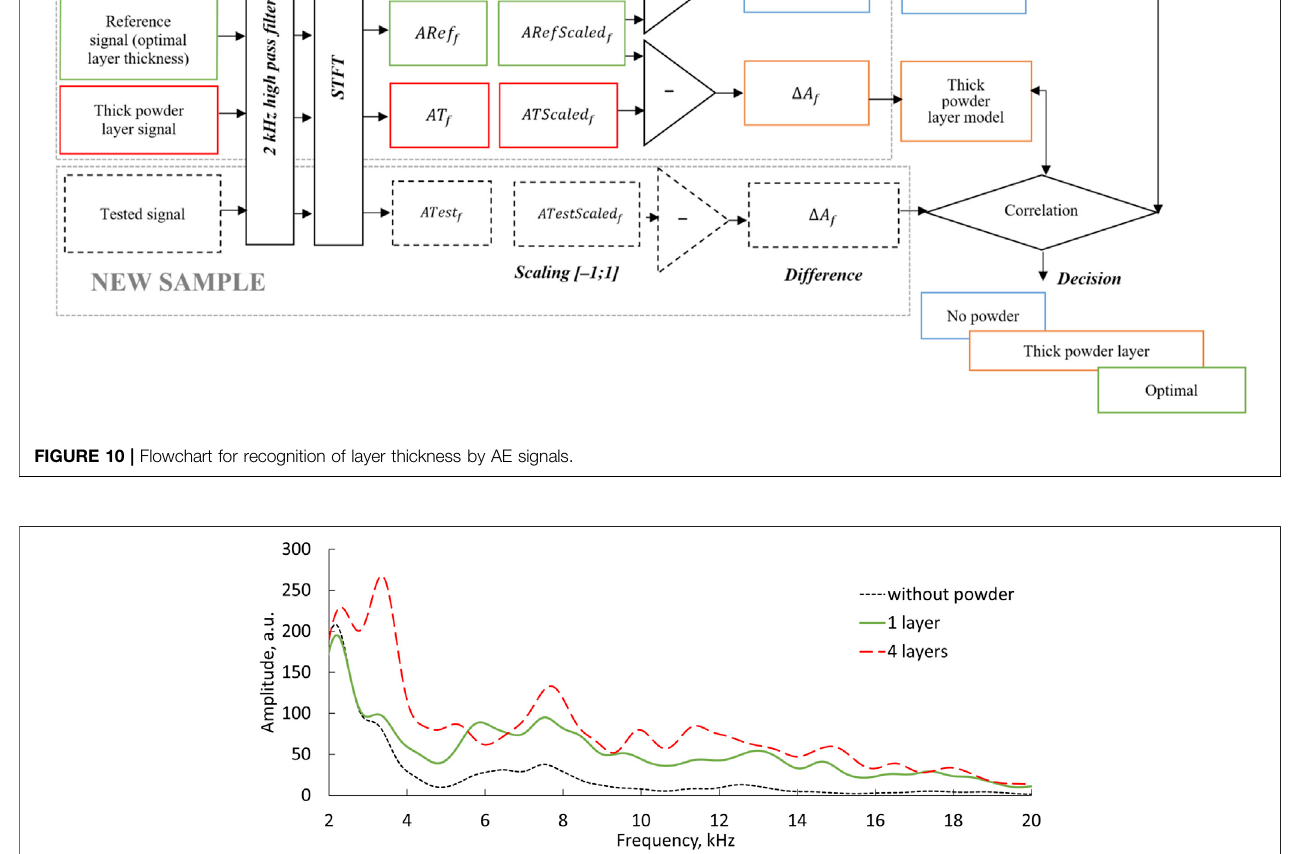
Frontiers in Mechanical Engineering |